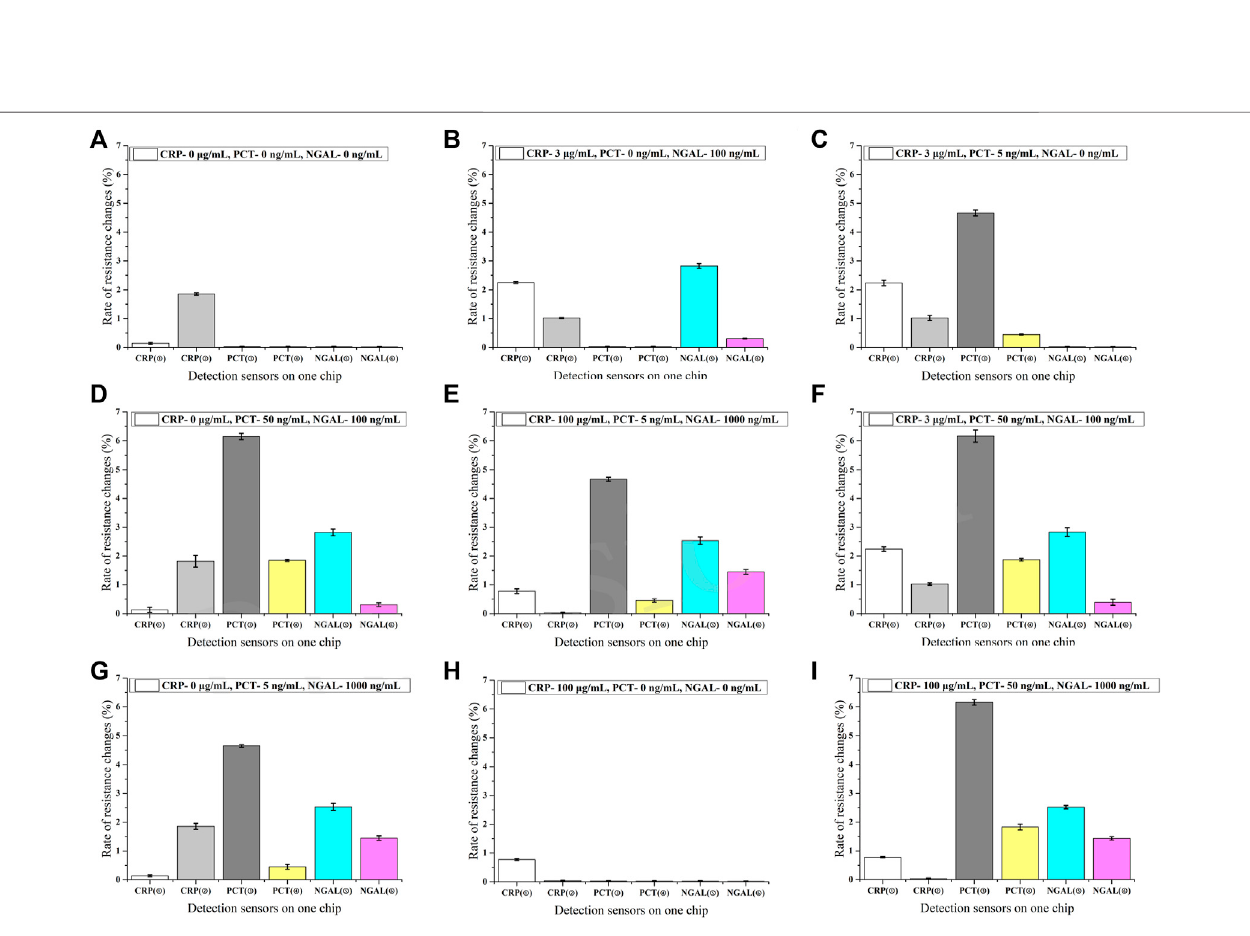
FIGURE 4 | Speci fi city of the assay ( n = 3) (A – I) . ① - ⑥ in the horizontal axis represents different sensors labeled in Figure 1